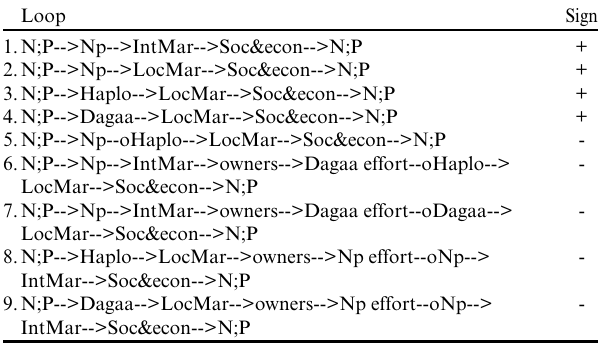
Table 1 . Enrichment loops and their signs. N;P = nitrogen and phosphorus; Np = Nile perch; IntMar = international market; Soc&econ = society and economy; LocMar = local and regional market; Haplo = haplochromines; Dagaa = Rastrineobola argentea ; --> = positive interaction; --o = negative interaction. Loop